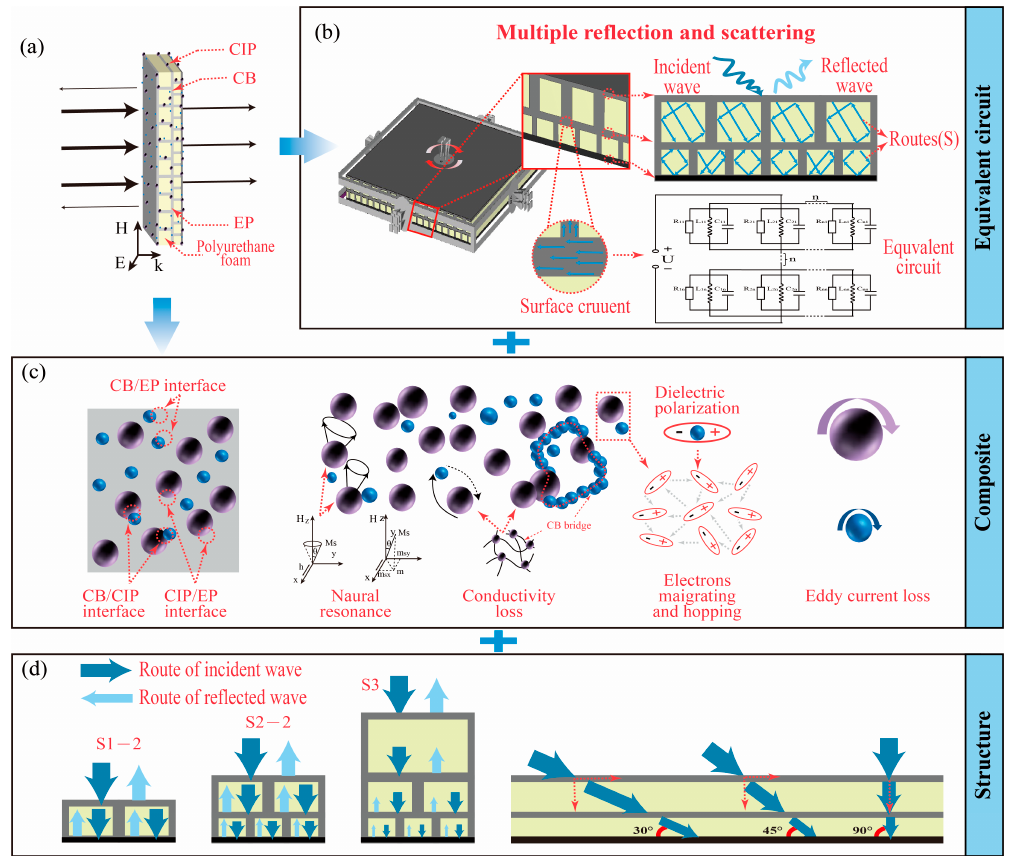
Figure 7. ( a ) The schematic diagram of EM wave incidence; ( b) the schematic diagram of the equivalent circuit; ( c ) the micro schematic diagram of EM-absorbing mechanisms; ( d ) the structural schematic diagram of EM-absorbing mechanisms.